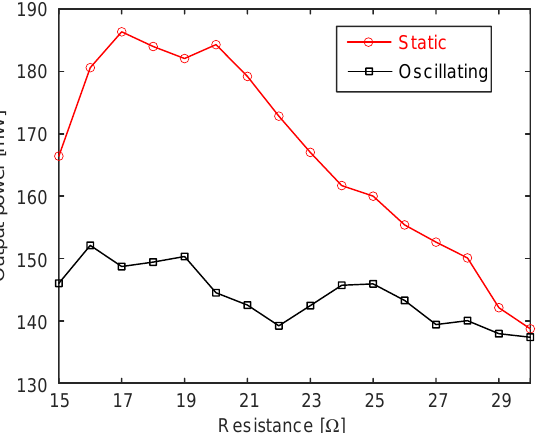
Figure 6. Solar panel output power with load resistance under static and dynamic conditions.